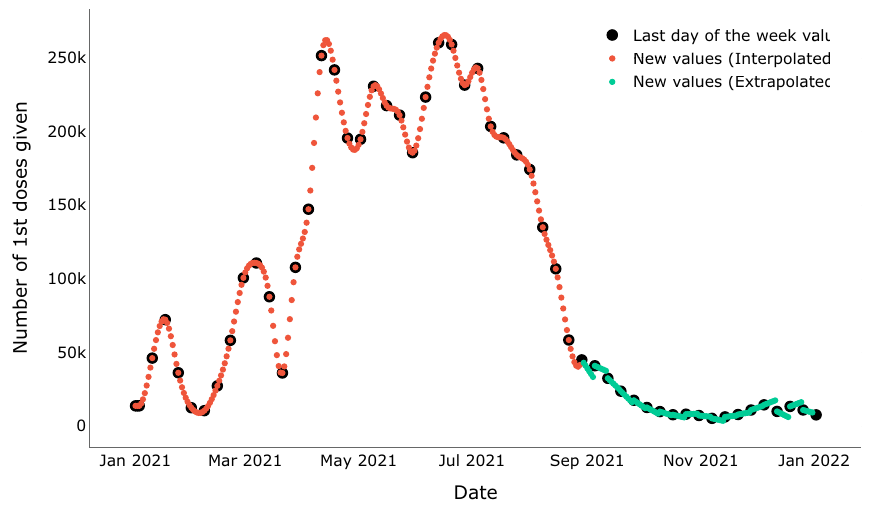
Figure 4. Interpolated and extrapolated values for each day of 2021 for the first dose of the